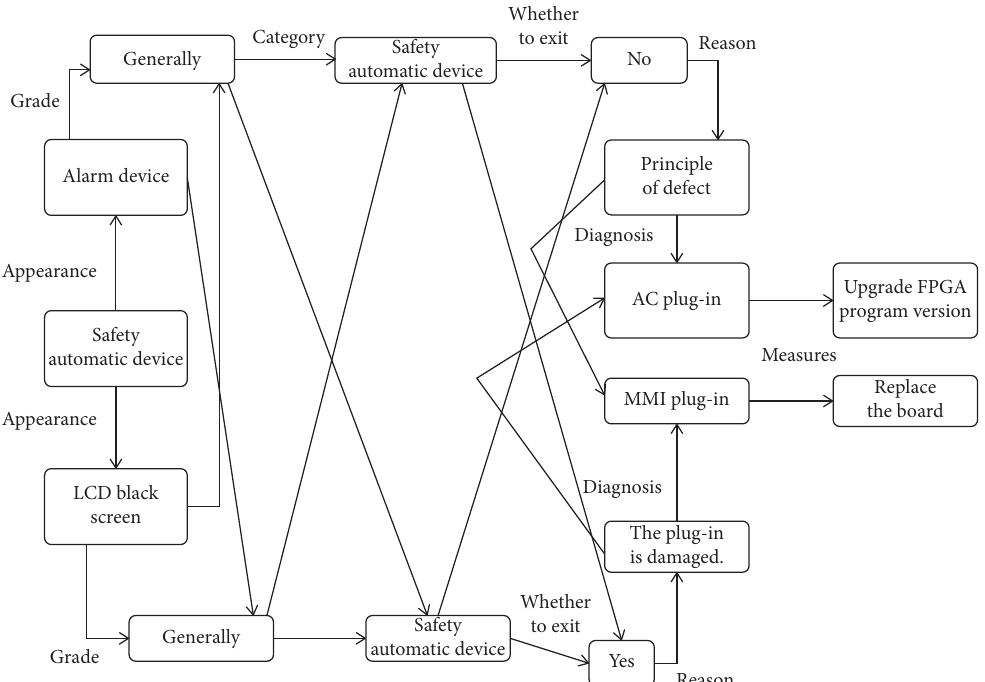
Figure 8: Subgraph of automatic safety